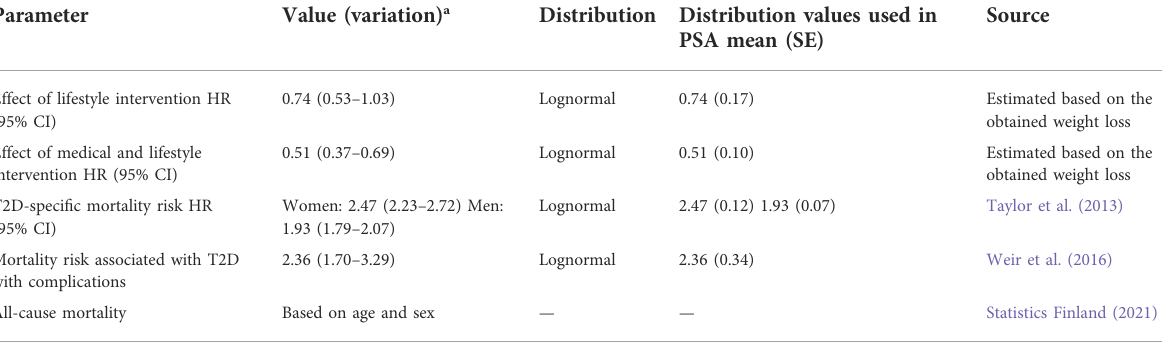
TABLE 1 Clinical parameters applied in the model, their distributions and the values used to estimate the